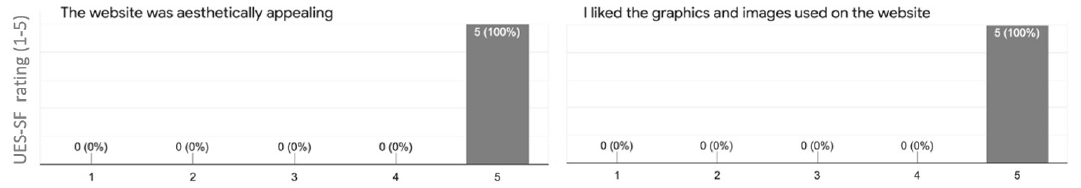
Figure 5. Participants unanimously rated ‘aesthetical appeal’ (left) and ‘graphics and images’ (right) with the top